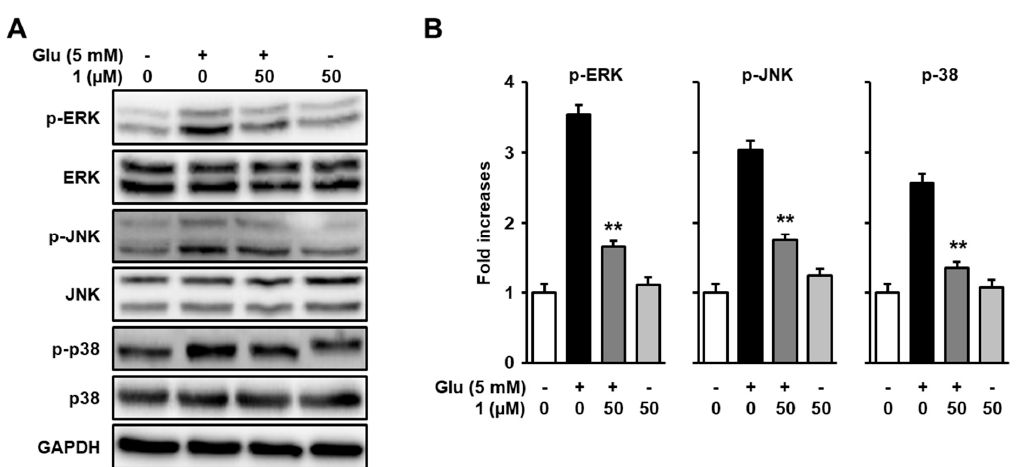
Figure 5. Glutamate-induced phosphorylation of MAPKs is inhibited by 1 . (A) HT22 cells were incubated with 5 mM glutamate and 50 µM of 1 for 8 h, which was followed by Western blot analysis. Immunoreactive bands were detected using antibodies for p-ERK, ERK, p- JNK, JNK, p-p38, p38, and GAPDH. (B) Bars denote the fold-increase of phosphorylation of MAPKs in the control (** p < 0.001 compared with glutamate-treated groups).